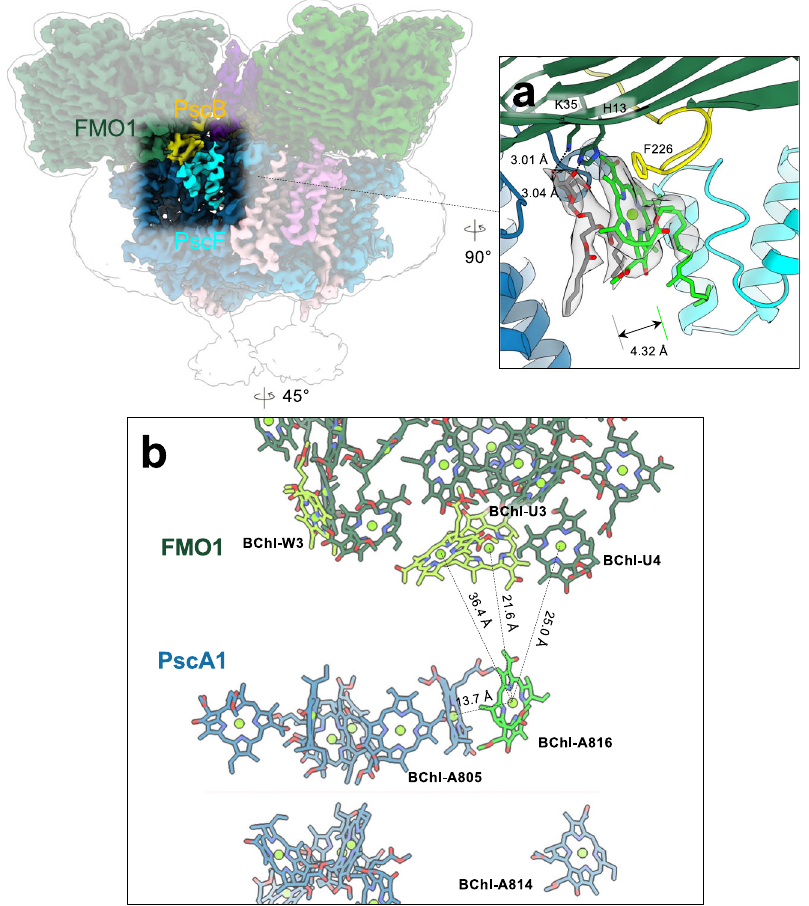
Fig.2|PotentiallinkerpigmentattheinterfacebetweentheFMOcomplexand the RC core. a Potential linker bacteriochlorophyll (BChl) at the FMO and RC interface. A BChl a (BChl-A816; light green) and an MGDG (monogalactosyl digly- ceride)lipid(gray)sandwichedbetweenPscF(cyan)andPscA1(blue)subunit.Gray surfaces are cryo-EM densities of the BChl and MGDG molecules (3.5 σ ). b Spatial